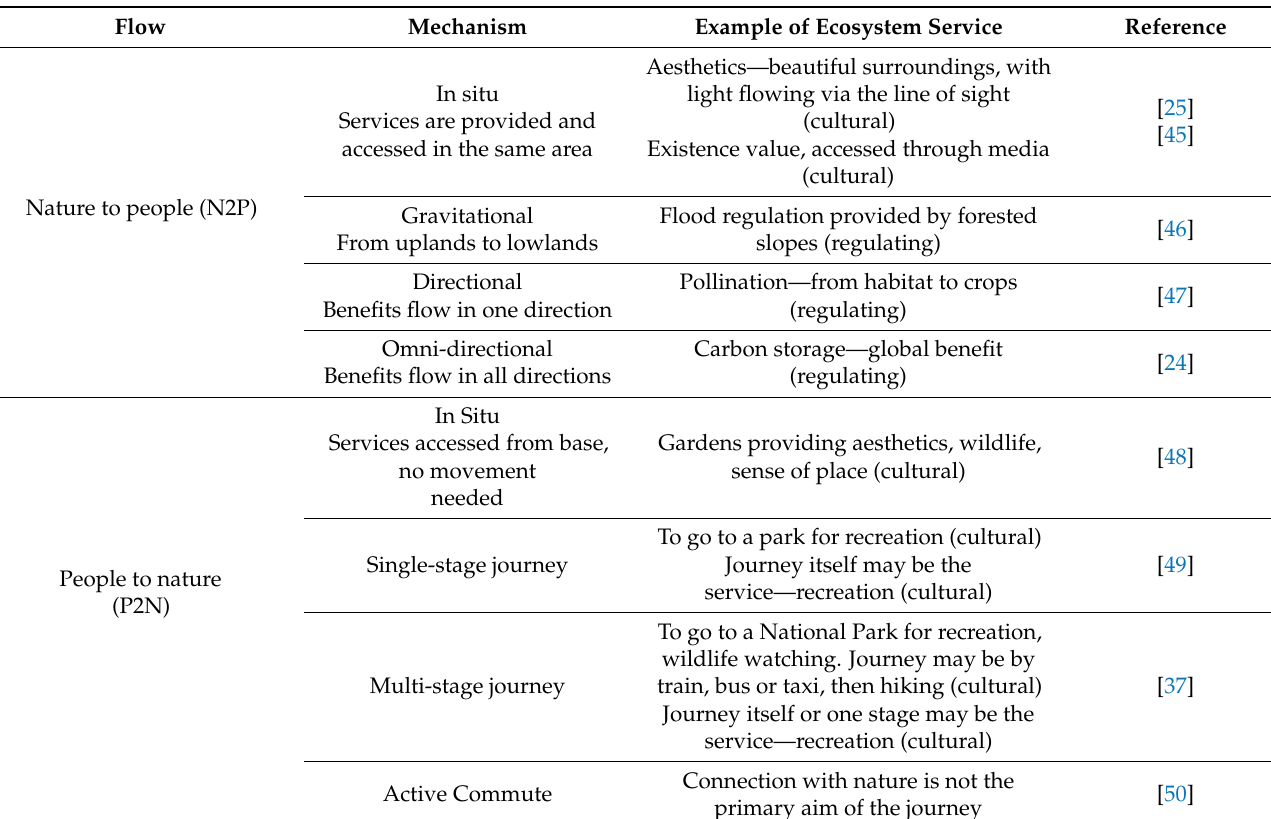
Table 1. Mechanisms to describe ES flow, broken down into ‘nature to people’ (the movement of a natural good to a transactor, where it is used by beneficiaries) and ‘people to nature’ (the movement of beneficiaries to a transactor in search of an ecosystem service). Mechanisms are based on the work of Fisher, Turner and Morling [44], with more recent ES examples. Flow Mechanism Example of Ecosystem Service Reference